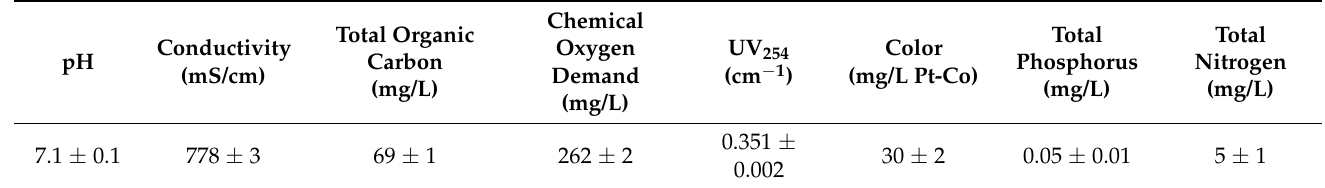
Table 2. Characteristics of real livestock wastewater, obtained from a livestock wastewater treatment plant in Jeollanam-do, Korea.